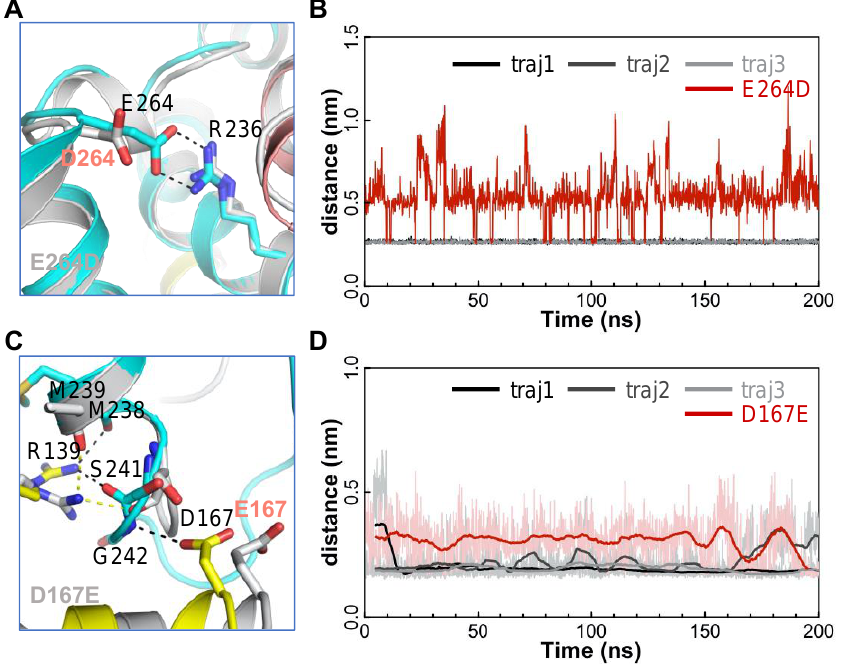
Figure 6. Structural changes in the simulations of E264D-AAC and D167E-AAC mutants. ( A ) Salt bridges between R236 and E/D264. ( B ) Time evolutions of minimum distances between residues 236 and 264 in the wild-type AAC (dark lines) and E264D-AAC mutant (red line). ( C ) The N-end of the M3 loop forms interactions with D/E167 and R137. ( D ) Time evolutions of minimum distances between residue 167 and the M3 loop in wild-type (dark lines) and D167E mutant AACs (red line). In ( A) and ( C ), the structures of domains 1, 2 and 3 are shown in salmon, yellow and blue, respectively.